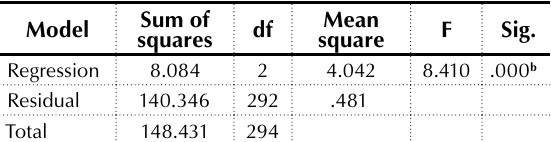
Table 10. Results of the second residual